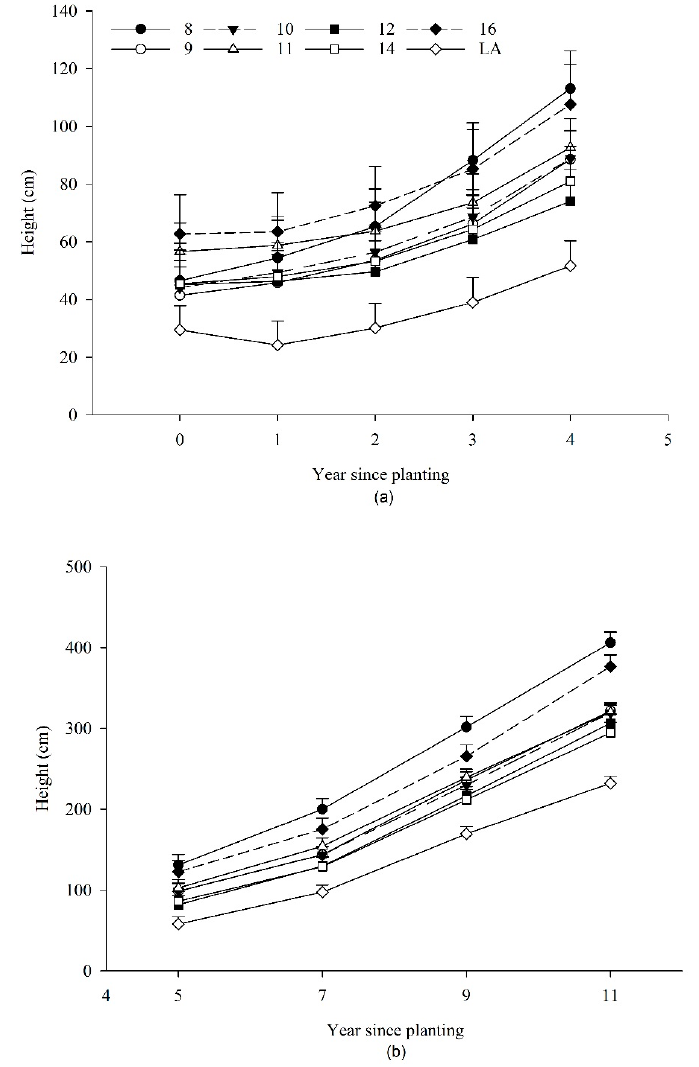
Figure 3. Height among families for years 0–4 ( a ) and 5–11 ( b ). Years are separated into two graphs to improve distinction among lines. Bars indicate standard error. LA indicates locally available seedling treatment.